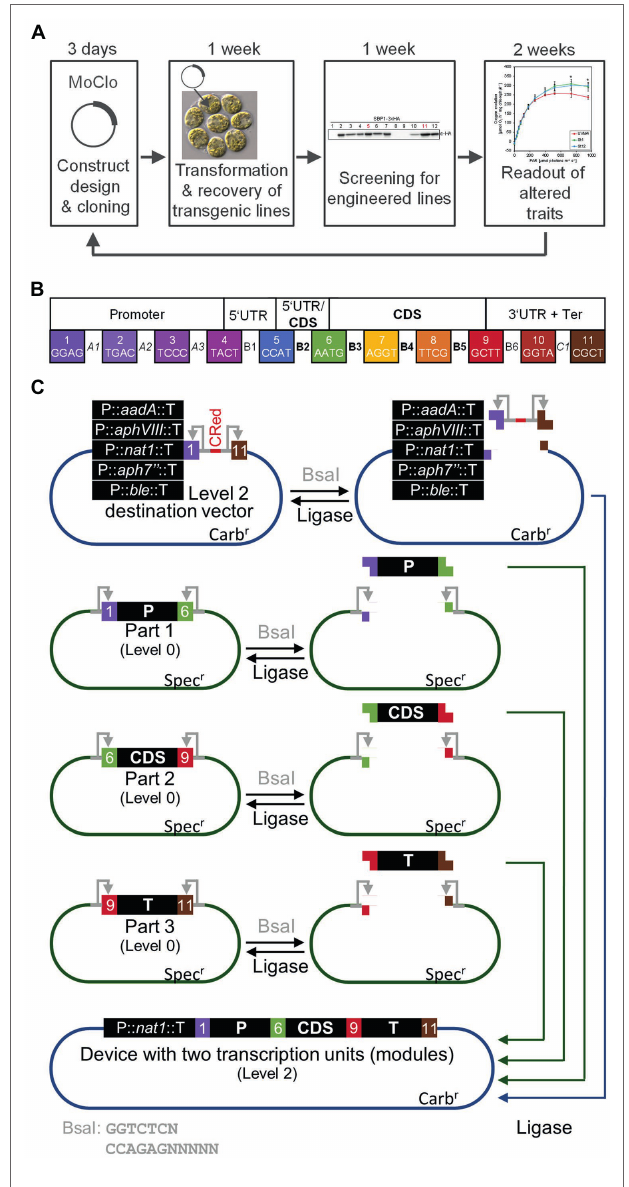
FIGURE 1 | The MoClo strategy in Chlamydomonas. (A) The iterative cycle of transgene design, building, testing, and learning (DBTL) can be achieved in 4–5 weeks with Chlamydomonas. (B) Plant MoClo syntax with the 11 fusion sites (4-nt overhangs) flanking the positions (A1–C1) for the individual parts of a transcription unit indicated by the color code (Patron et al., 2015; Crozet et al., 2018). (C) Directional assembly of a transcription unit (or module) into dedicated Chlamydomonas level 2 destination vectors. Standardized genetic parts are released from level 0 vectors by digestion with BsaI (gray). Exemplarily, three parts representing promoter (P, position A1-B2), coding sequence (CDS, position B3-B5), and terminator (T, position B6-C1) are shown. Recognition sites for BsaI remain on the vector (gray arrows). In the same reaction, one of five dedicated level 2 destination vectors is digested. Here, the BsaI recognition sites are released with the insert containing the bacterial CRed operon for canthaxanthin biosynthesis allowing red/white color selection. Since T4-DNA ligase is present in the same reaction, genetic parts can be religated into their level 0 source vector and the insert can be religated into the level 2 destination vector. However, both can be cut out